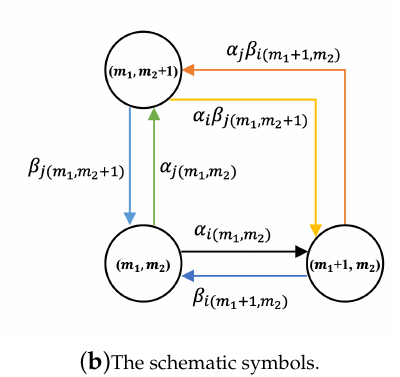
Figure 4. The detailed state transition